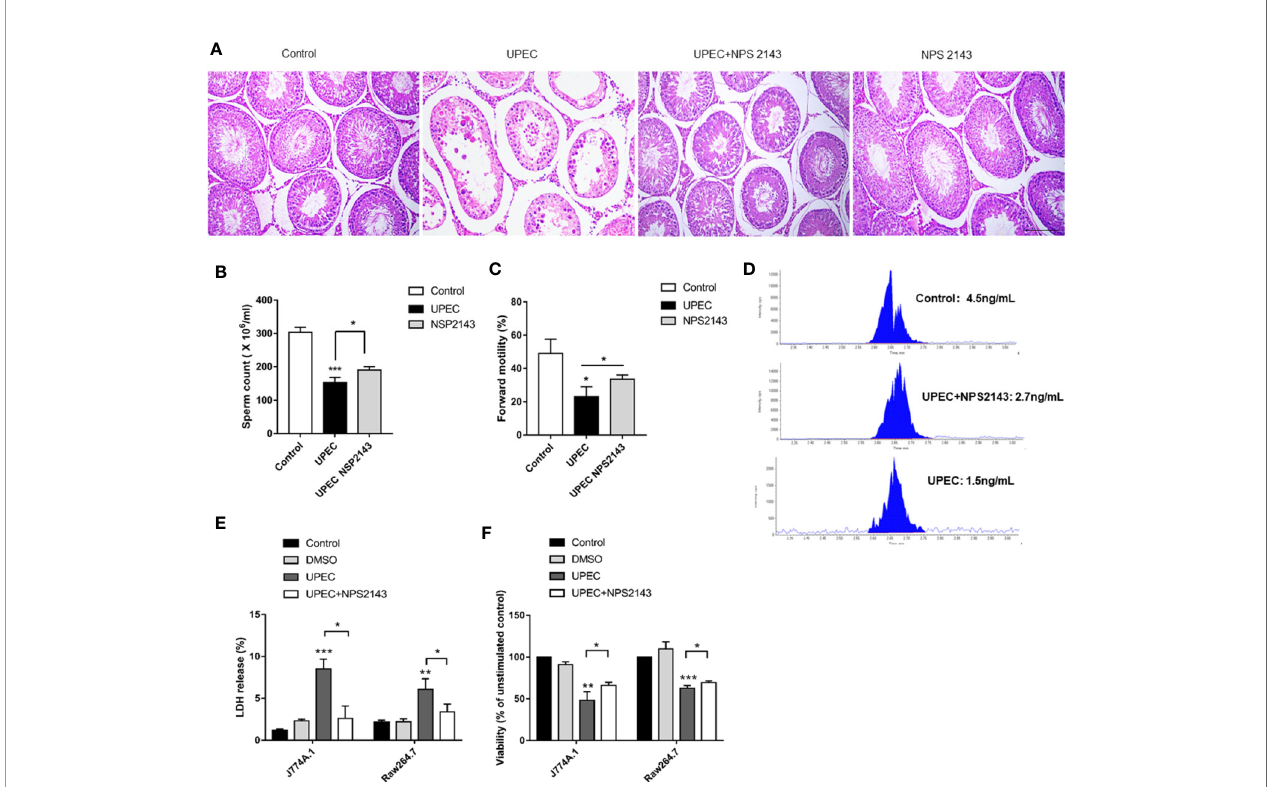
FIGURE 3 | CaSR inhibitor NPS-2143 can reduce UPEC-induced testicular in fl ammatory damage. (A) The morphology of the testicular tissues in the normal saline control group was intact; UPEC infection group showed obvious the irregular arrangement of spermatogenic epithelium, in fi ltration of in fl ammatory cells in the interstitium, and the destruction of many spermatogenic cell structures; UPEC+NPS-2143 inhibitor group. The in fl ammatory injury of the testis was relieved; the NPS- 2143 negative control group showed no signi fi cant changes compared with the saline control group. Scale bar 100 um ( n =5/group). (B) Comparison of the total number of sperm in normal saline control group, UPEC infection group, and NPS2143 rats ( n =5/group). (C) The comparison of the forward movement speed of spermatozoa in the three groups ( n =5/group). (D) The testosterone levels in the sera of rats were detected by LC-MS. (E) Assessment of LDH release from macrophage cell lines J774A.1 and Raw264.7 by UPEC strain. (F) Neutral red stains the macrophage cell lines J774A.1 and Raw264.7 in each group. * P < 0.05, ** P < 0.01, *** P < 0.001 ( t